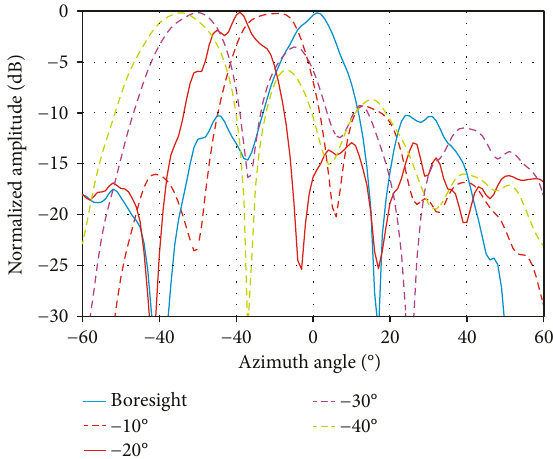
Figure 18: The measured normalized radiation patterns for beam- steering angles in the azimuth